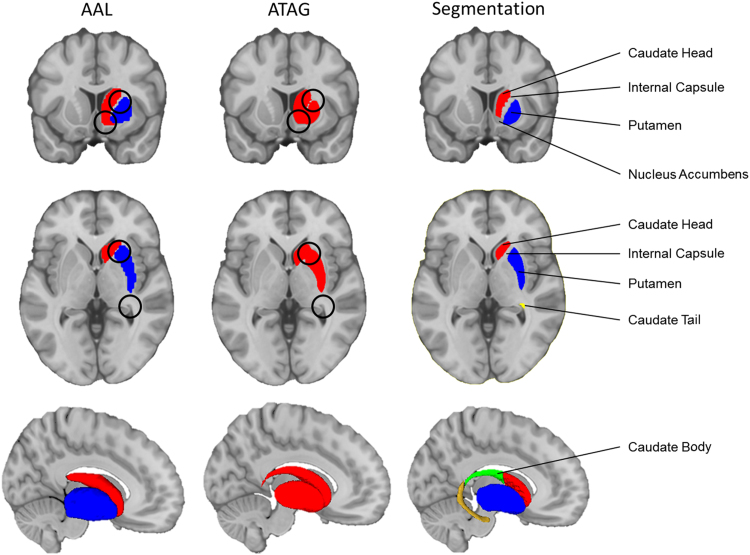
Segmentation of the striatal subregions. The three columns compare the AAL and ATAG atlases with our manual segmentation. The top row shows the coronal section, the middle row shows the axial section, and the bottom row shows the 3D rending of the structures in the sagittal plane. The relevant structures are labelled, and the differences are marked with black circles. Anatomical underlay and subcortical renders are displayed in MNI space.